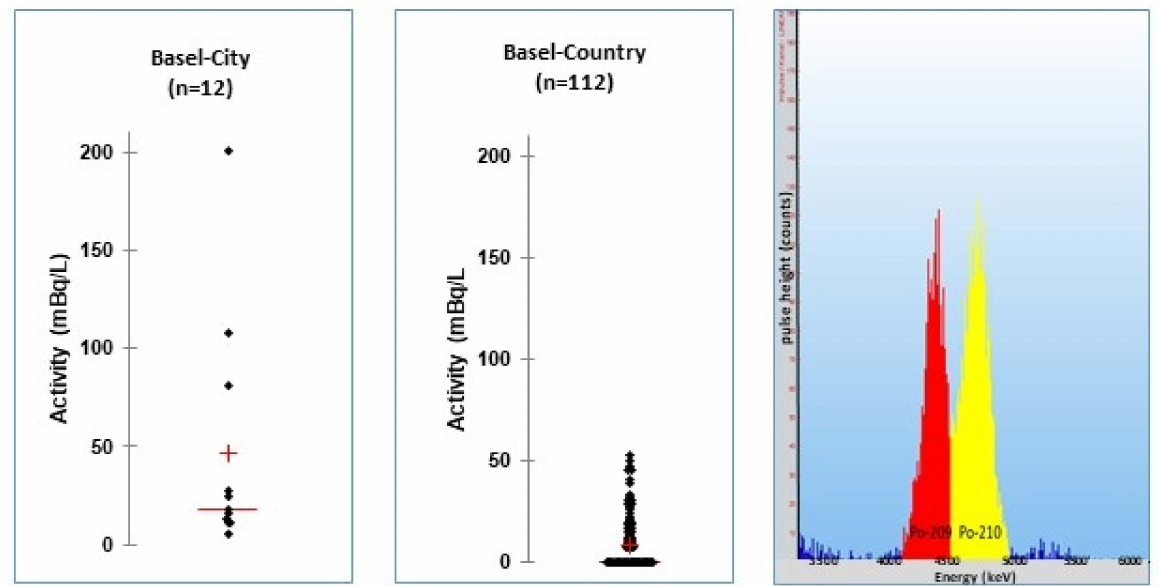
Figure 4. ( Left , middle ): Distribution of the 210 Po activities in the tap water of the villages of the two states Basel–City and Basel–Country. ( Right ): PERALS spectrum of a 210 Po standard with its tracer 209 Po (each about 100